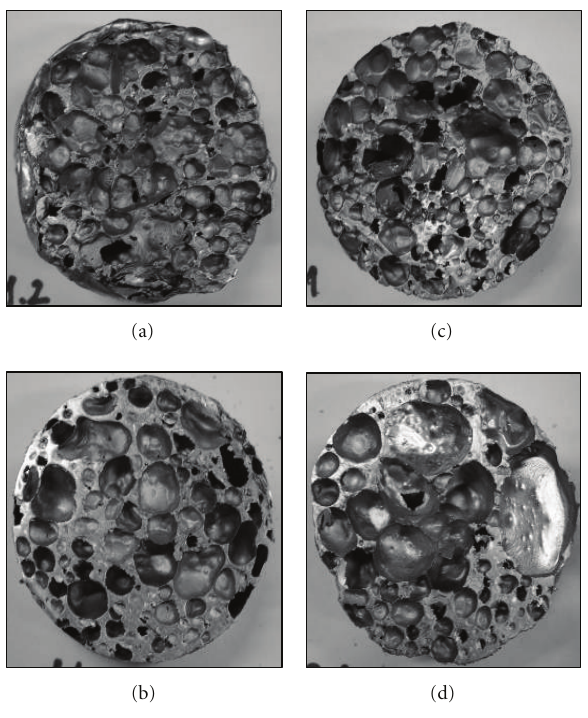
Figure 11: Cross section of sample showing skin region (SM, nitrogen, ambient). Figure 12: Di ff erent pore shape using di ff erent pressure and at di ff erent thickness position: (a) upper and (b) lower slice at ambient pressure; (c) upper and (d) lower slice with suction ( ∅